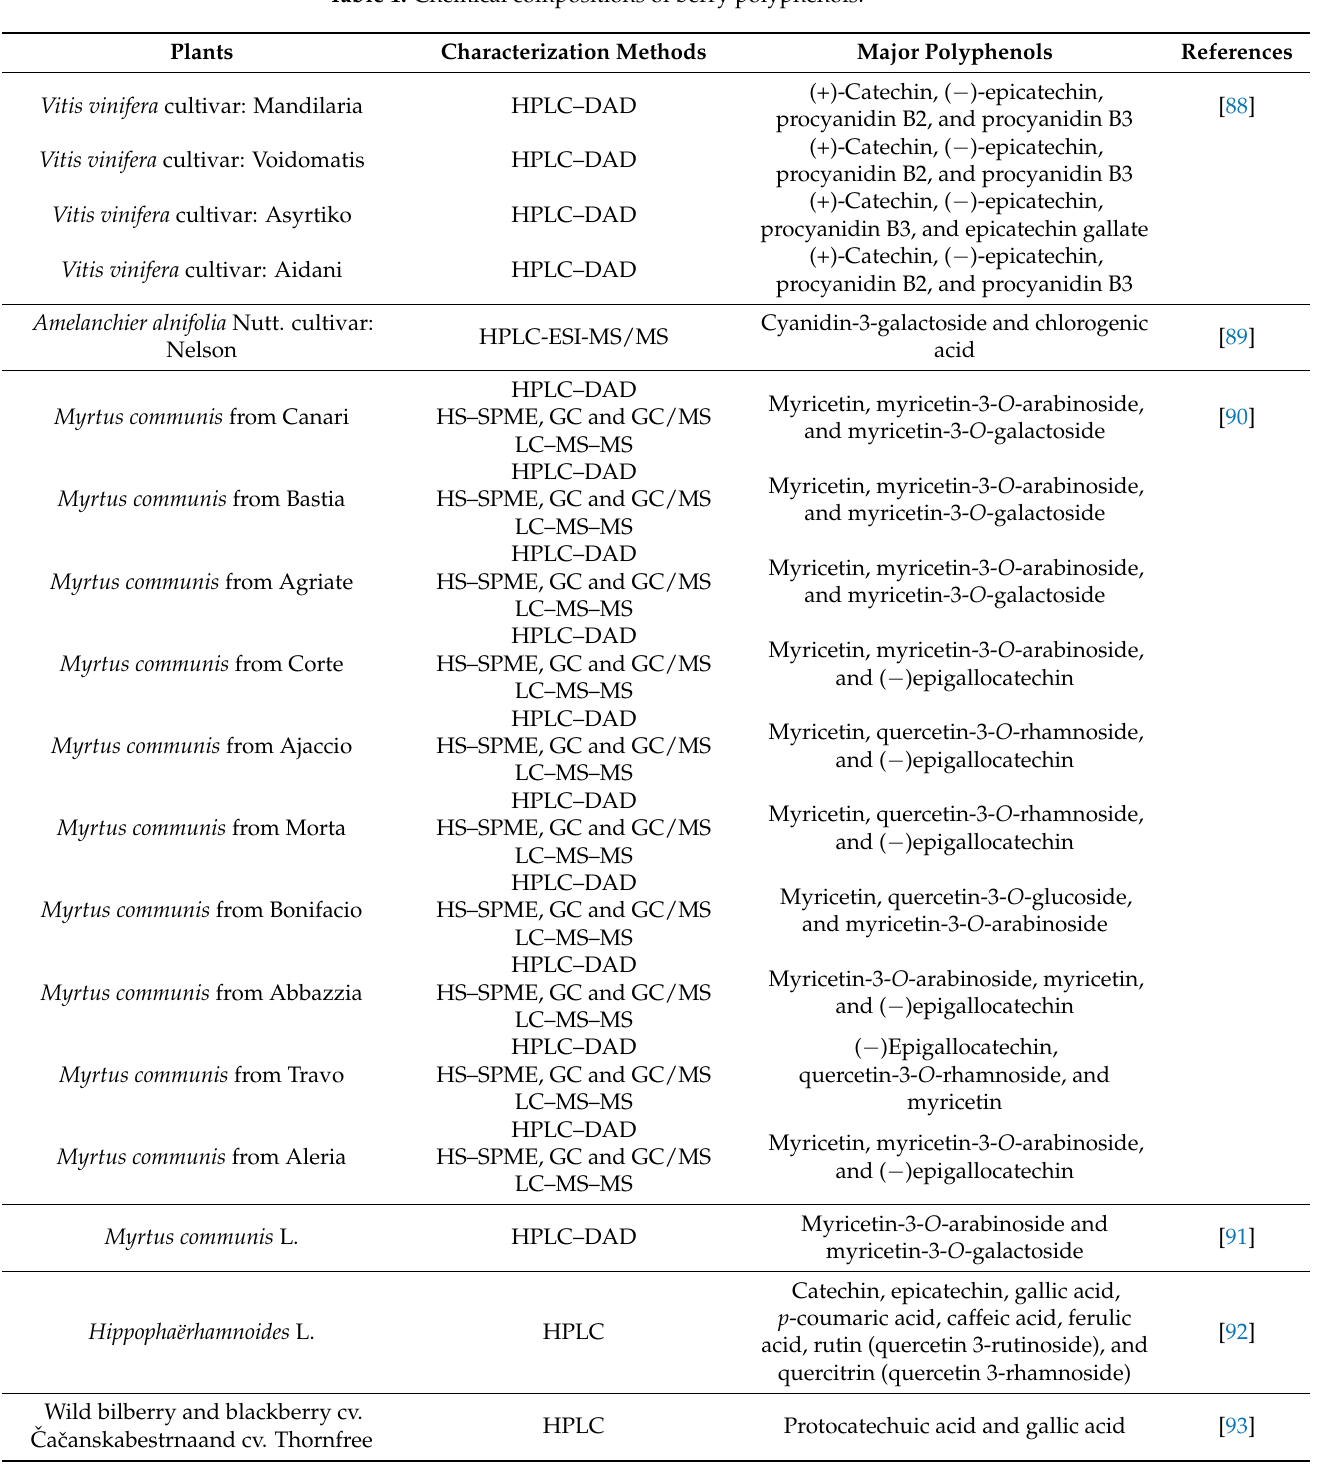
Table 1. Chemical compositions of berry